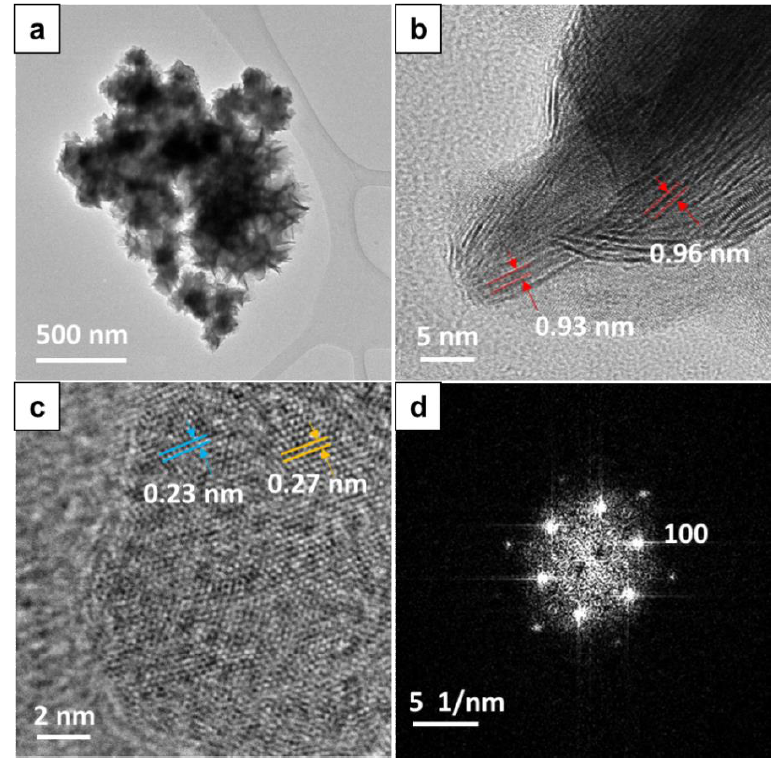
Figure 3. ( a ) TEM image; ( b , c ) HRTEM image and ( d ) selected-area electron di ff raction (SAED) pattern of the W 2 C / WS 2 _4h NF sample. Nanomaterials 2020 , 10 , x FOR PEER REVIEW